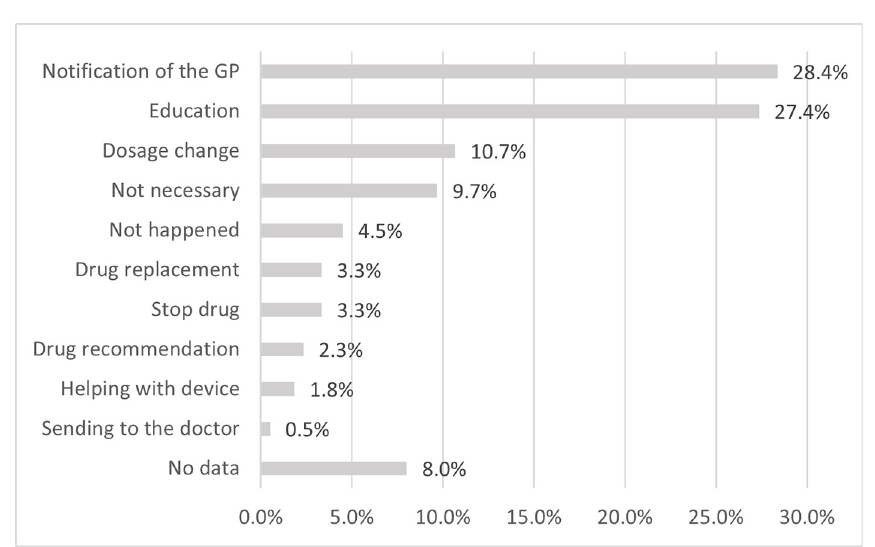
Fig 6. The incidence of pharmacist interventions to solve interaction risks, in order of frequency. GP: General practitioner; n =